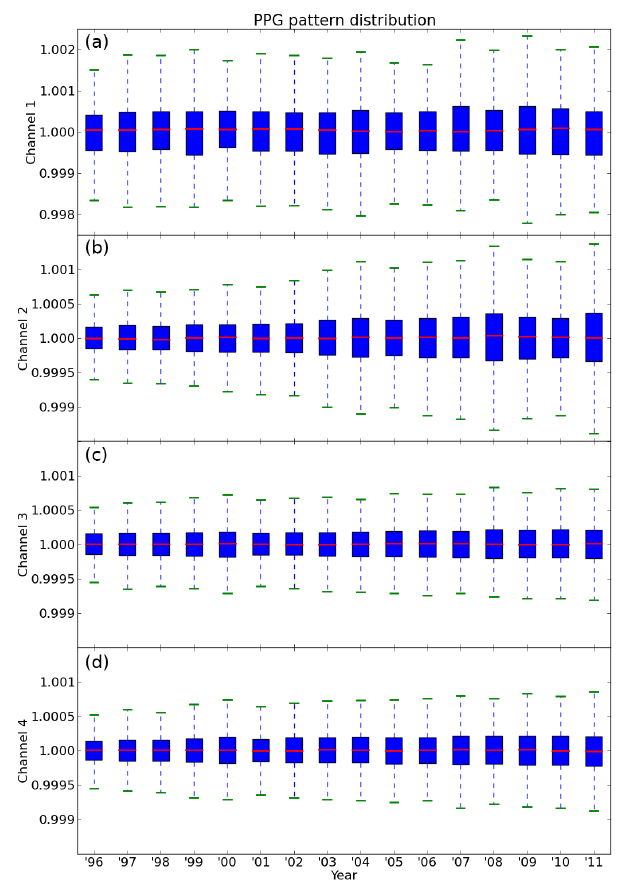
Figure 19. Box–whisker plots of the distribution of the PPG cor- rection pattern as a function of time (one selected distribution per year) for channels 1, 2, 3, and 4 (a–d) . Note the slightly different y axis range for channel 1. Red horizontal lines denote the median, the blue boxes denote the lower (25%) and the upper (75%) quar- tile, and the green caps denote the minimum and maximum values (except the